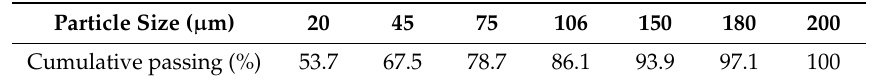
Table 2. Grain size distribution of the tailings